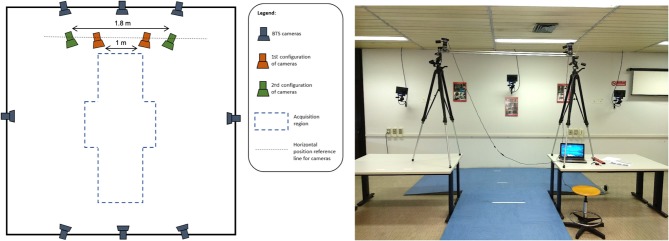
Laboratory setup, schematic (left) and pictorial (right) view.